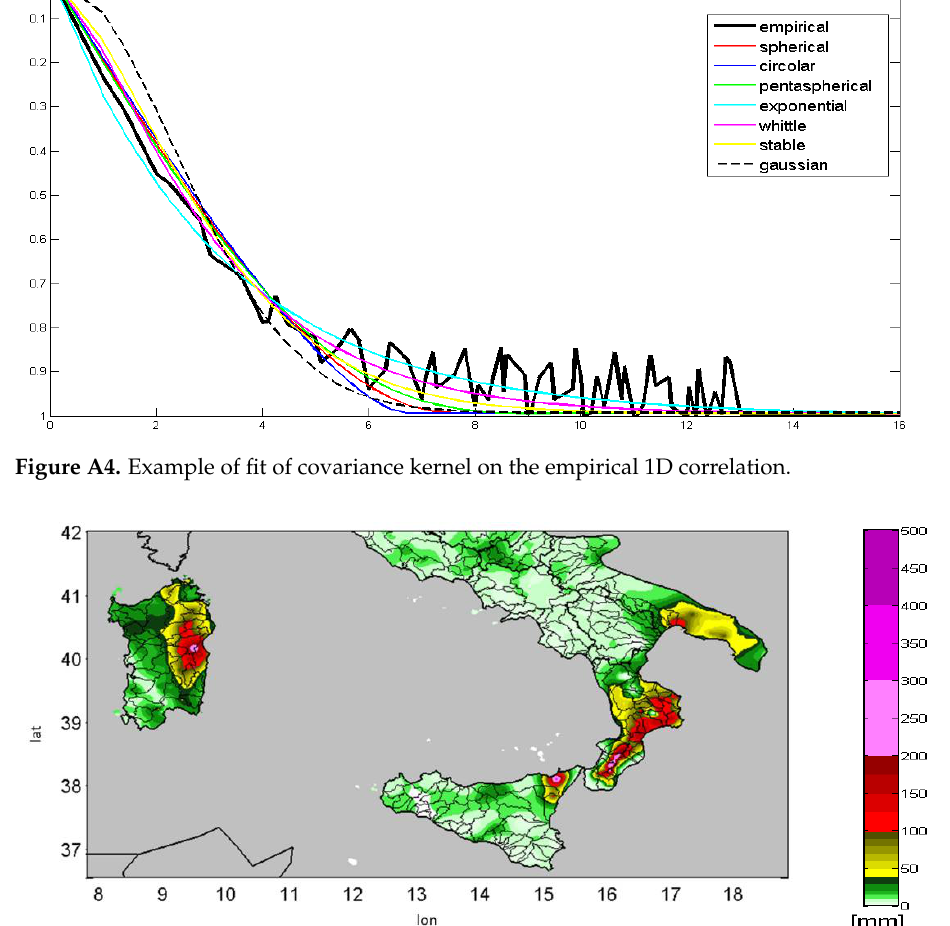
Figure A5. Example of GRISO interpolation of the rain gauge observations.